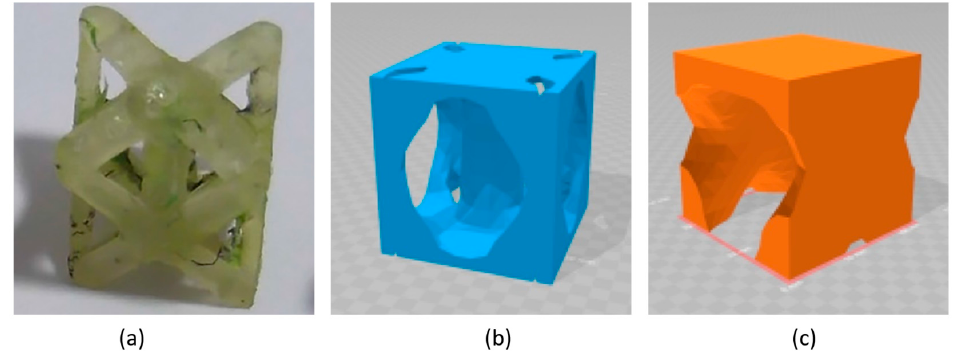
Figure 24. Multifunctional unit-cell prototypes proposed by Beringer et al. and Lee et al. [26,91]. ( a ) Maxwell truss [91]. ( b ) Compressive unit-cell [26]. ( c ) Shear unit-cell [26]. An analogous solution was also proposed by Lee et al. [26], who created a numerical tool for the evaluation of the optimal multifunctional configurations using a density- based method based on solid isotropic material with penalization model (SIMP) [93]. A multiobjective function based on a weighted sum approach of the normalized stiffness and ionic conductivity was used to evaluate the multifunctional performance of the bi- phasic solution. A RESNET [94] framework was applied for the numerical estimation of the electric performance, while the mechanical behavior of the unit-cell microstructures and multi-cell specimens were studied using a finite element approach considering two separate loading conditions: the uniaxial compression (see Figure 24b) and the simple shear (see Figure 24c). In contrast to the work shown by Beringer et al. [91], this activity proposed a solution where the ionic conductivity was anisotropically optimized along the direction of the ion flow, guaranteeing a greater margin in the structural stability for the same electrical performance. Optimal configurations were in this way numerically de- fined for each loading condition, and four different multifunctional unit-cells were man- ufactured. The cells with a different geometry but the same volume fraction of solid set to 0.5 were mechanically tested under compression and shear while the ionic conductivity was measured after backfilling the empty part of the cells with a 3 M KCl-based liquid elec- trolyte. The electrolyte was carefully selected to assure that there were no electrochemical reactions between the acrylonitrile butadiene styrene (ABS), copper electrodes and the electrolyte. Test specimens were mounted in a specially designed test rig and immersed in the KCl solution. Normalized results, reported in Figure 25, proved the capability of topological optimization as a valid support for multifunctional materials. Despite the lack of any electrodes, the morphological optimized structural electrolyte is a valid alternative to explore for the realization of future structural batteries.